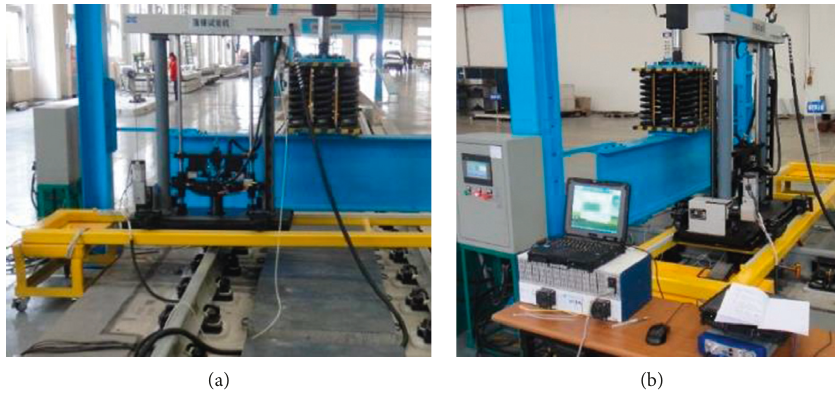
Figure 12: Drop weight experimental